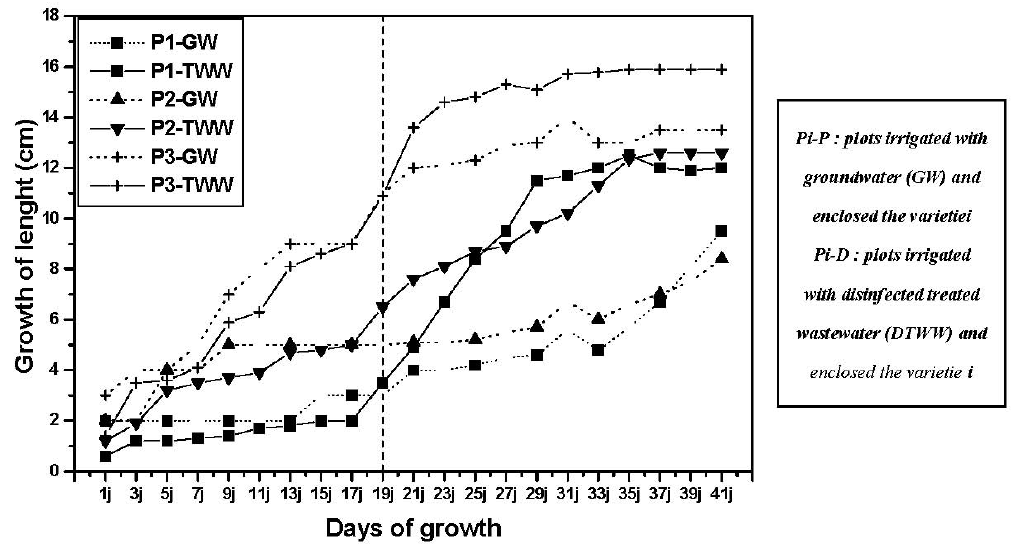
Figure 5. Evolution of the length of leaves in the irrigated plots with the two qualities of water: groundwater and disinfected treated